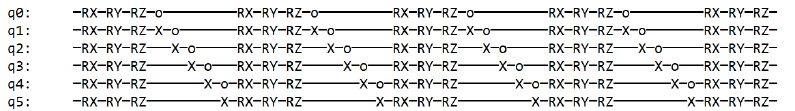
Figure 11. Parametrized quantum circuit used for approximated amplitude encoding. The circuit was composed of four layers made of rotation gates and five C-NOT gates plus a final layer composed only of rotation